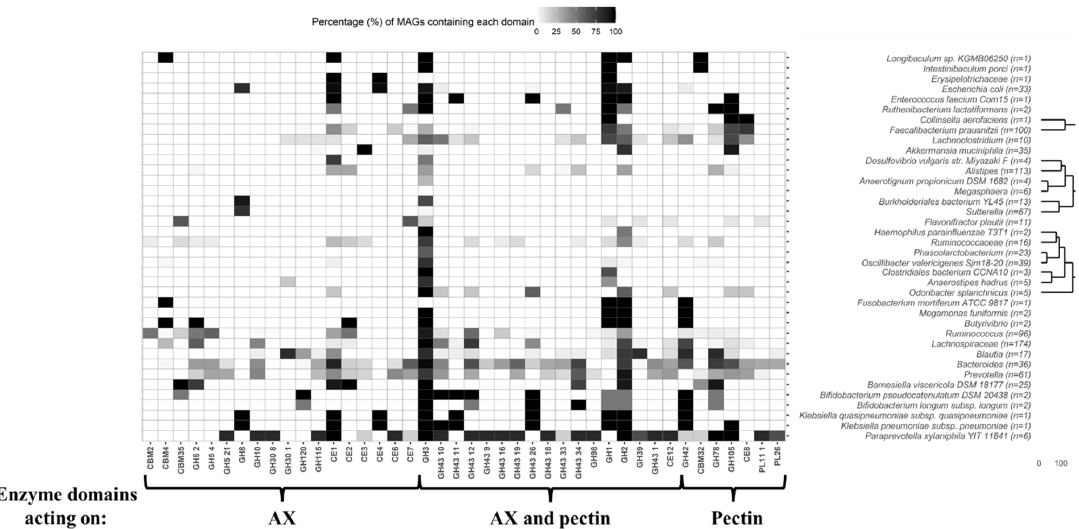
Figure 3. Heatmap showing the presence of different glycosidases (indicated as black cells) in metagenome-assembled genomes (MAGs) recovered from the microbiota of patients with Crohn’s disease. These MAGs were assigned to taxonomic clades that were also found in the microbiota of healthy individuals (see Table 1). The percentage (%) of MAGs containing each functional domain is shown. Specifically, glycosidases capable of degrading arabinoxylan (AX) and pectin are illustrated. Glycosidase functional domains showing coverage values higher than 0.95 were annotated. Codes corresponding to the Carbohydrate-Active enZYmes Database (CAZy) family of each enzyme have been assigned.